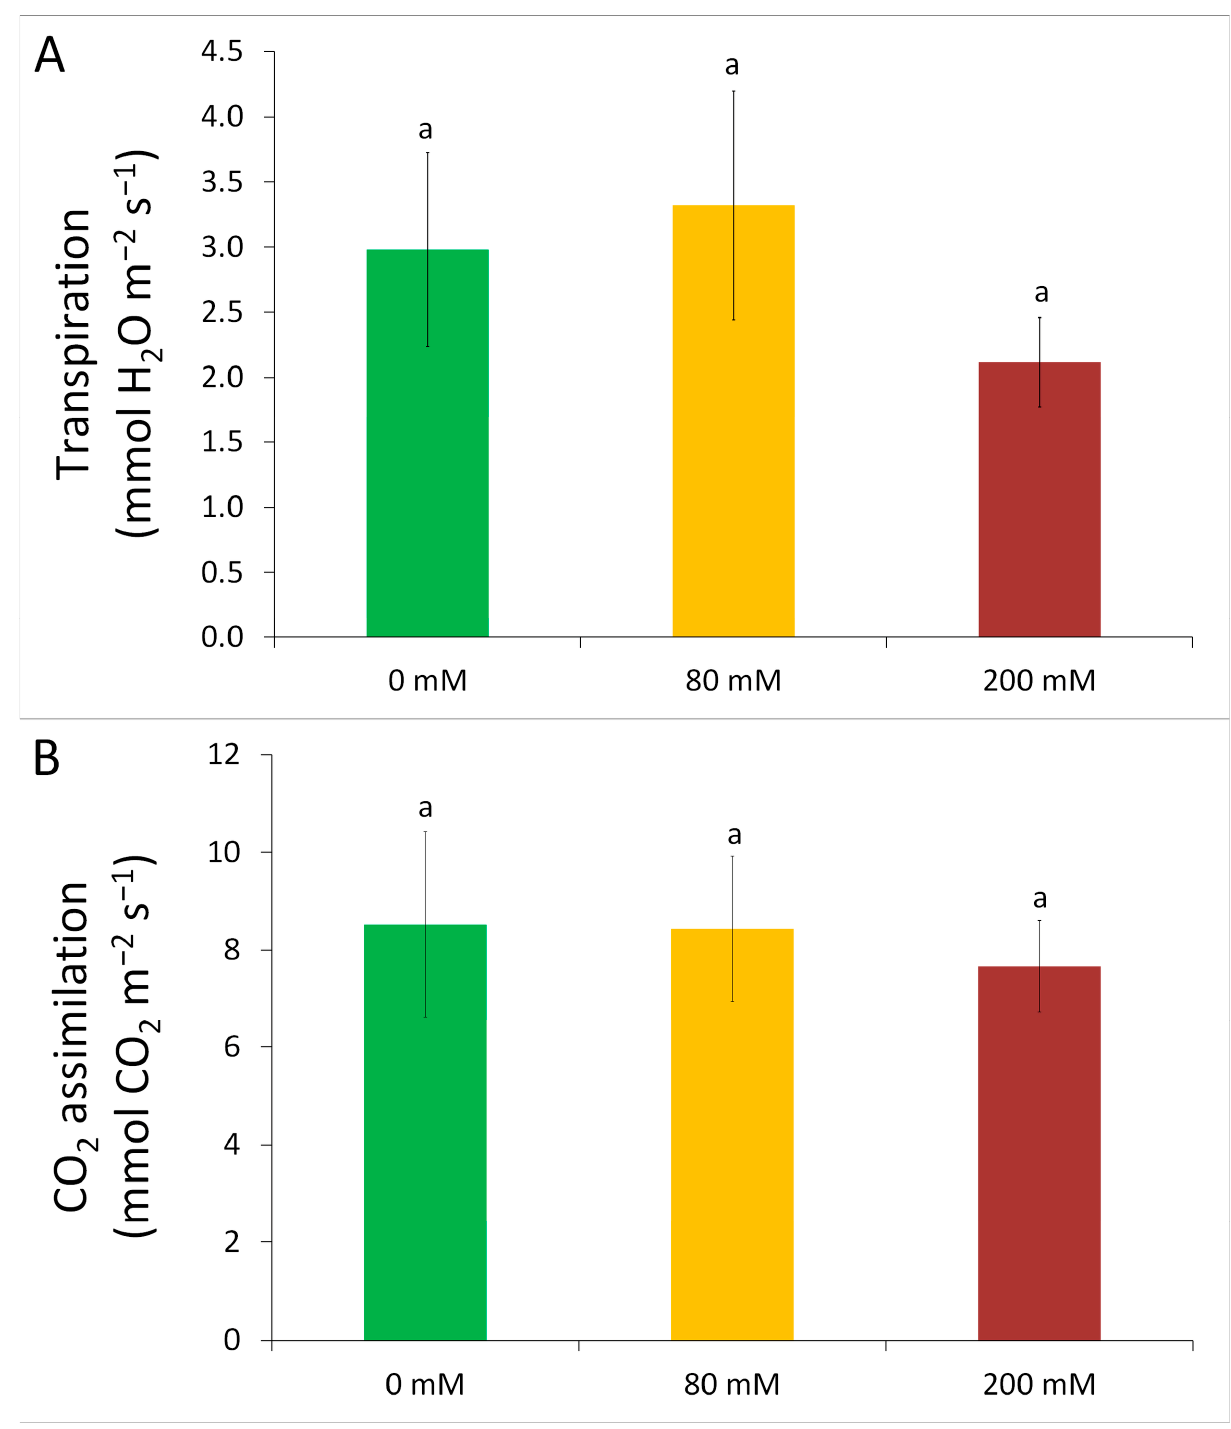
Figure 2. Transpiration rate ( A ) and CO 2 assimilation ( B ) recorded in Arundo donax leaves after 1 month of alkaline salt treatment. Error bars represent SD values. To compare the differences, one- way ANOVA was performed on each dataset with Tukey’s post-hoc test on the treatments ( p < 0.05). Same lowercase letters indicate there are no significantly different